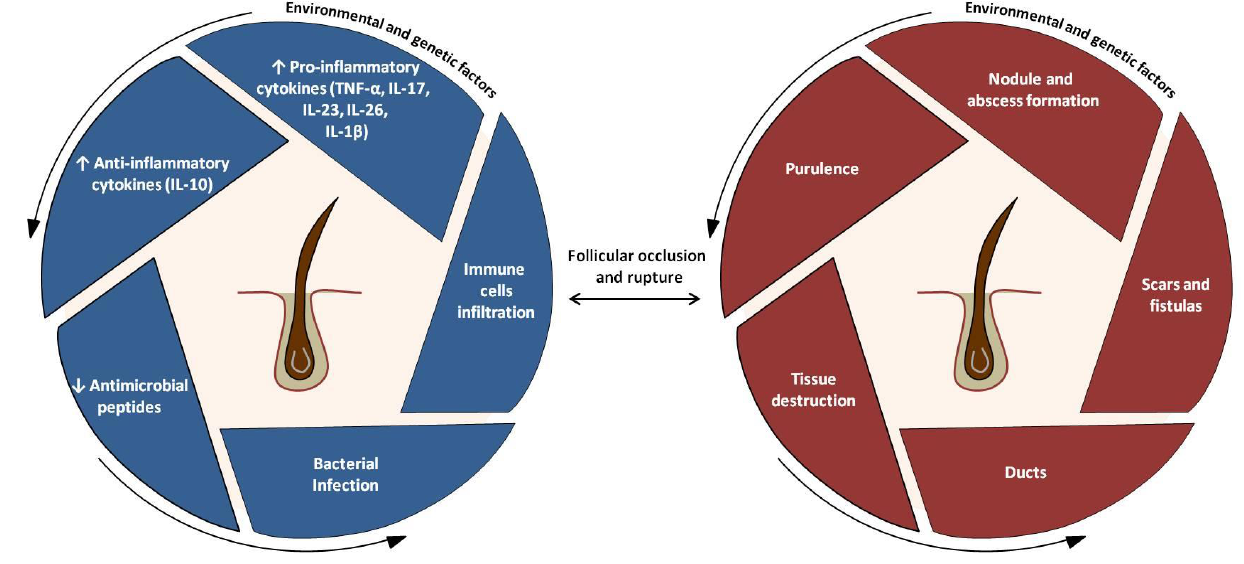
Figure 3. Pathophysiology of HS: a schematic overview.